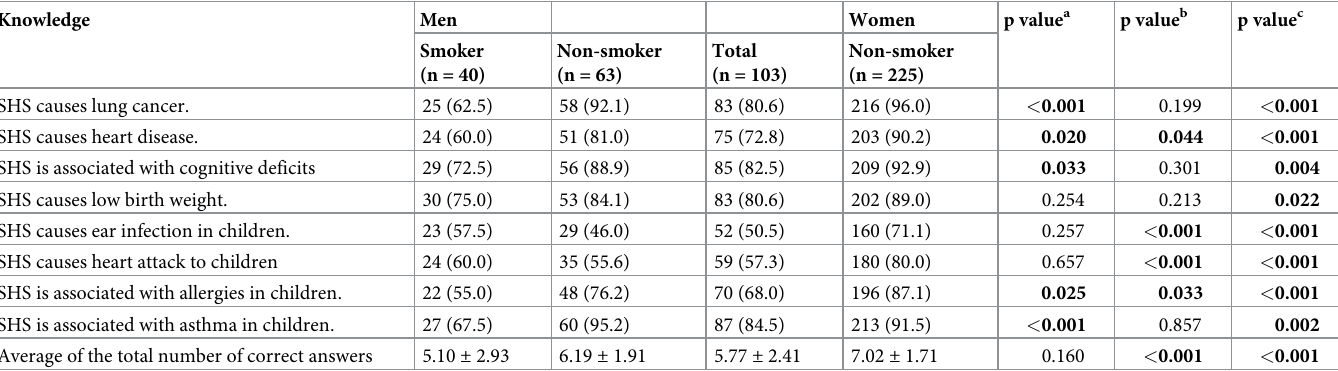
Table 2. Percentage of correct answers about SHS knowledge according to gender and smoking status.